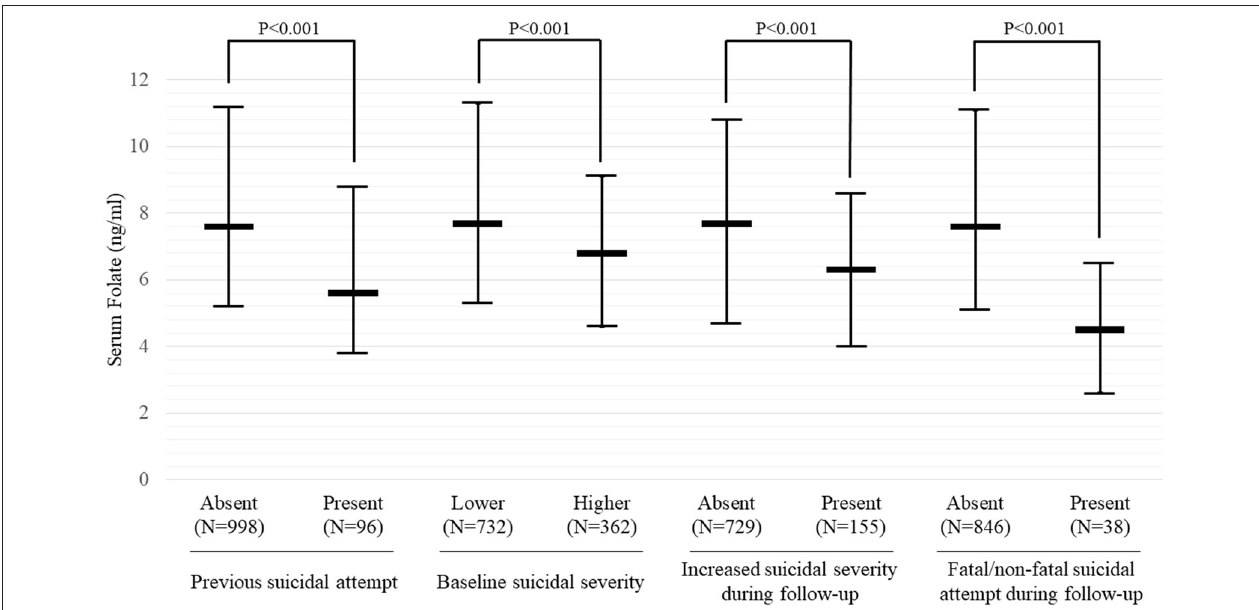
FIGURE 2 | Serum folate levels according to suicidal behavior in patients with depressive disorders. Data are shown as median and interquartile range. Baseline suicidal severity was defined using the brief psychiatric rating scale (BPRS) suicidality item scores, divided into lower [1 (not present) to 3 (mild)] and higher [4 (moderate) to 7 (extremely severe)]. Increased suicidal severity was defined as any instance of an increase in BPRS suicidality item score during the 12-month pharmacotherapy period.